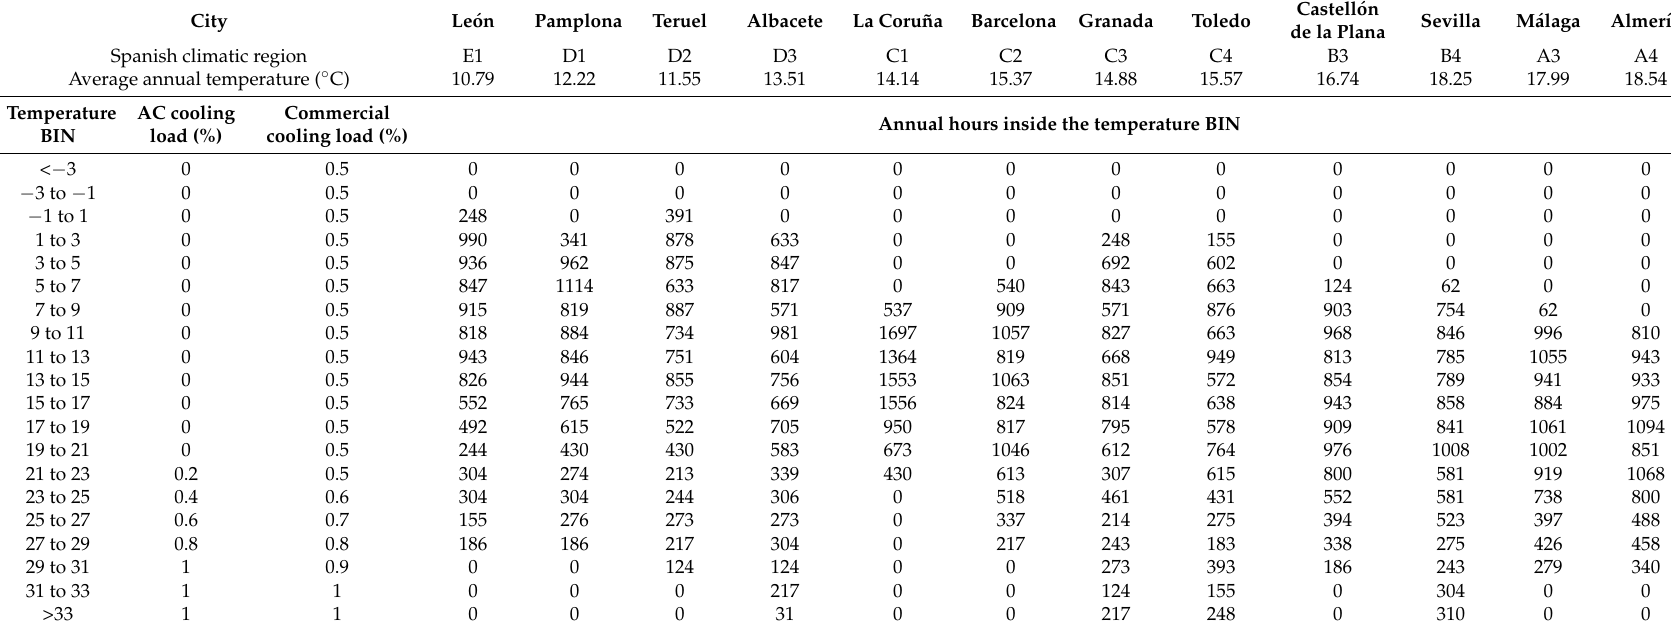
Table 1. Reference Spanish cities for the evaluation of the systems. Climatic regions, temperature BINs, hours of operation and cooling load